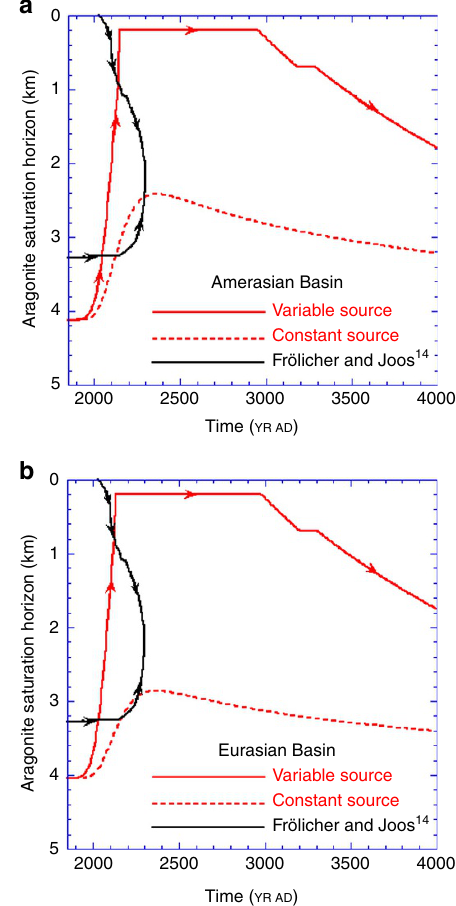
Figure 5 | Predicted evolution of the aragonite saturation horizon. The arrows indicate the direction of change on a given line segment. ( a ) The position of Z sat in Amerasian Basin with our model (red lines) and that predicted in Fro¨licher and Joos 14 (black line). ( b ) The position of Z sat in the Eurasian Basin from our model (red lines) and that predicted in Fro¨licher and Joos 14 (black